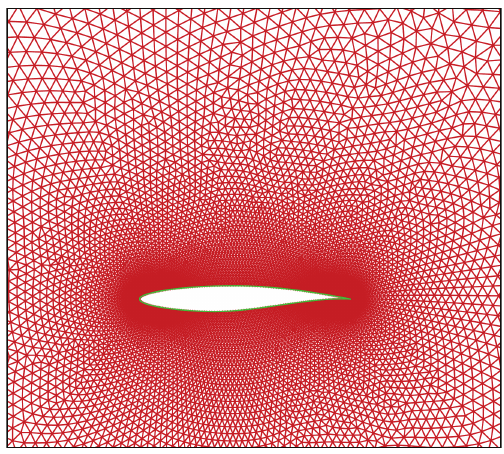
Figure 1: Initial (unadapted) RAE2822 airfoil mesh.